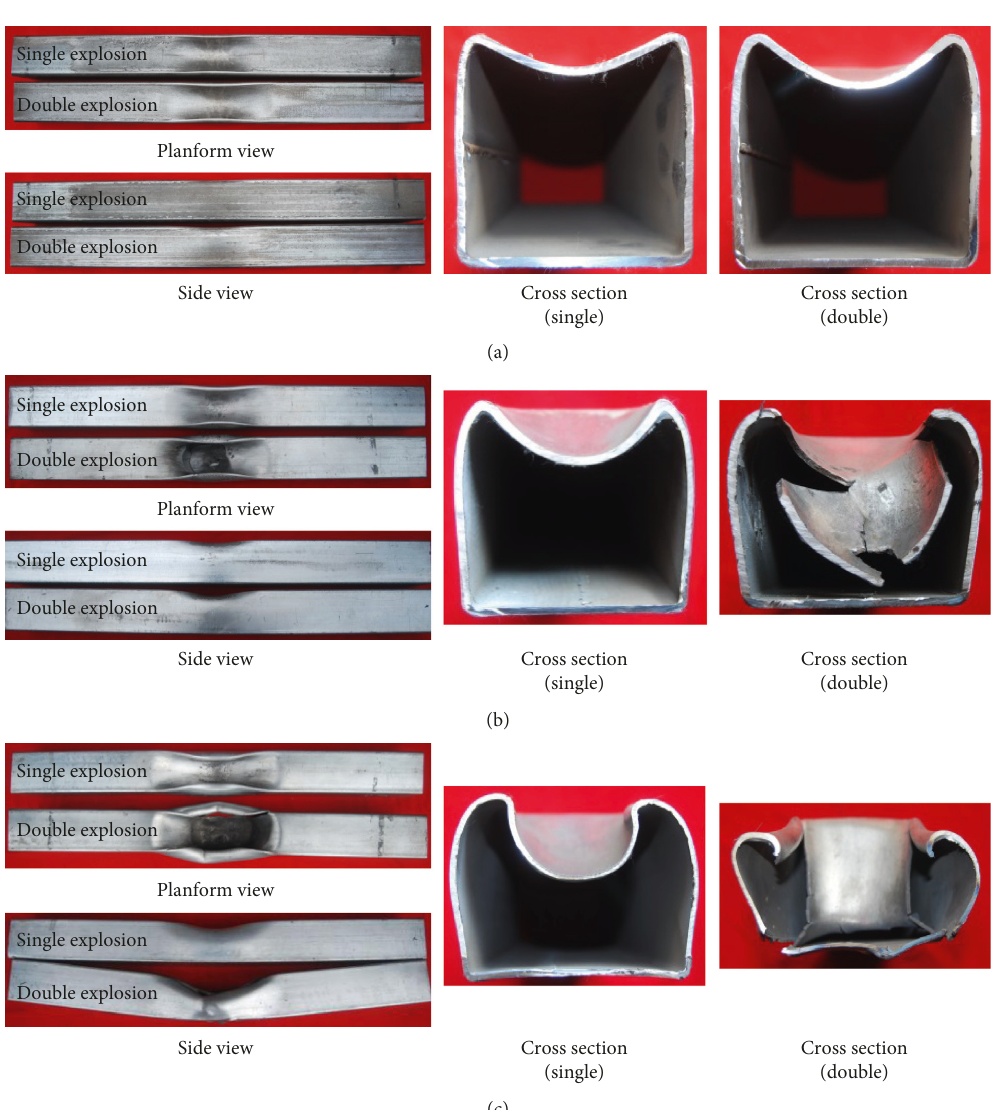
Figure 8: The deformation and damage comparison of square tubes subjected to single and double explosions. (a) a � 4.0mm, R � 20cm. (b) a � 3.5mm, R � 14 cm. (c) a � 3.0mm, R �